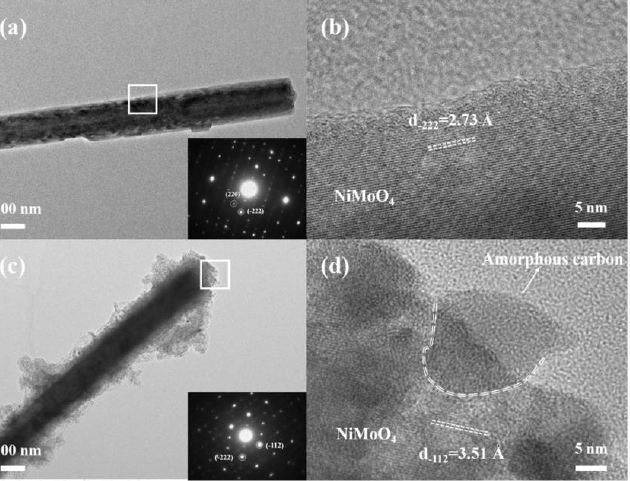
Figure 5. TEM images ( a , c ) and HRTEM micrographs ( b , d ) of pure NiMoO 4 NWAs ( a , b ) and NiMoO 4− x @C ( c , d ) samples. The insets in ( a , c ) are corresponding SAED patterns taken from a single nanowire.